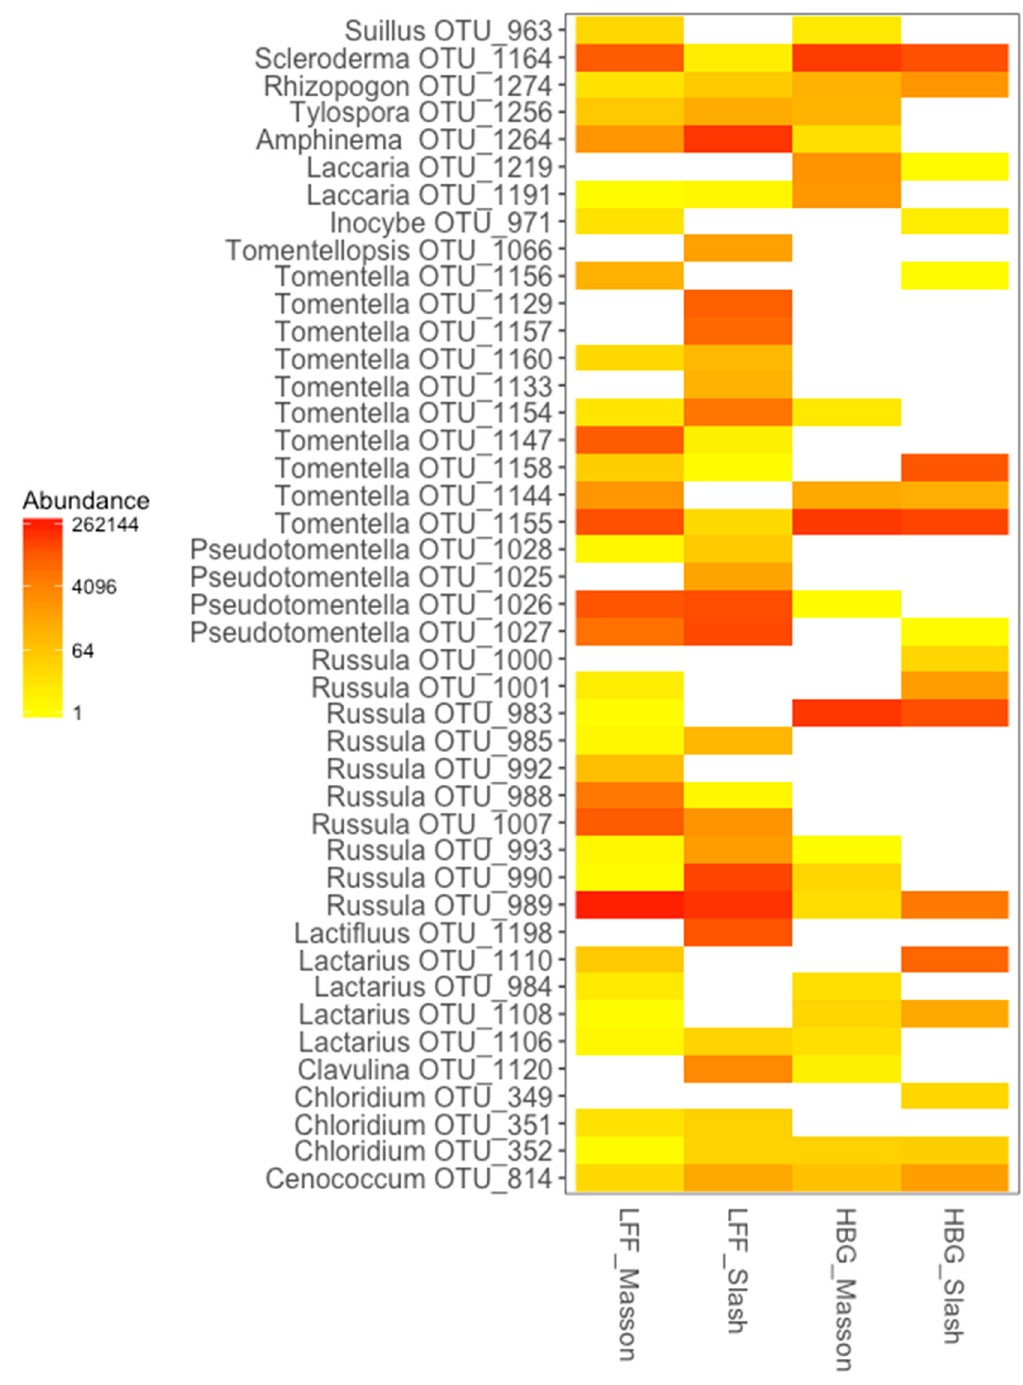
Figure 1. Ectomycorrhizal fungal operational units (OTUs) showing sequence read abundance across sites for each pine host. LFF—Longli Forest Farm; HBG—Hunan Botanic Garden.